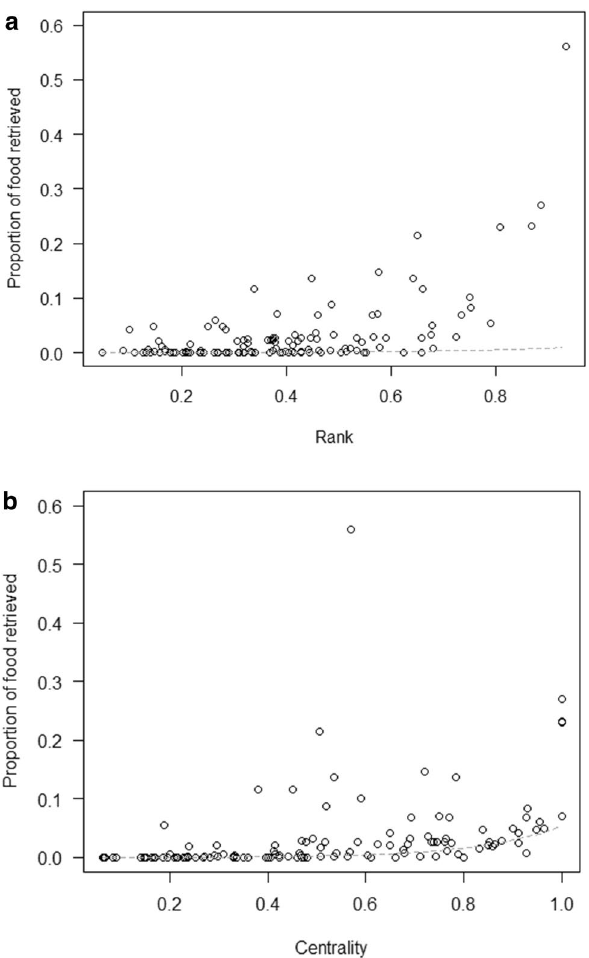
Figure 3. Mean proportion of food retrieved by the study subjects in the social tolerance task, as a function of their ( a ) rank and ( b ) Eigenvector centrality (see model 2). Circles represent the study subjects and are jittered to avoid overlap. The dashed line depicts the model, which has been back-transformed from the log-odds ratio scale and contains standardized